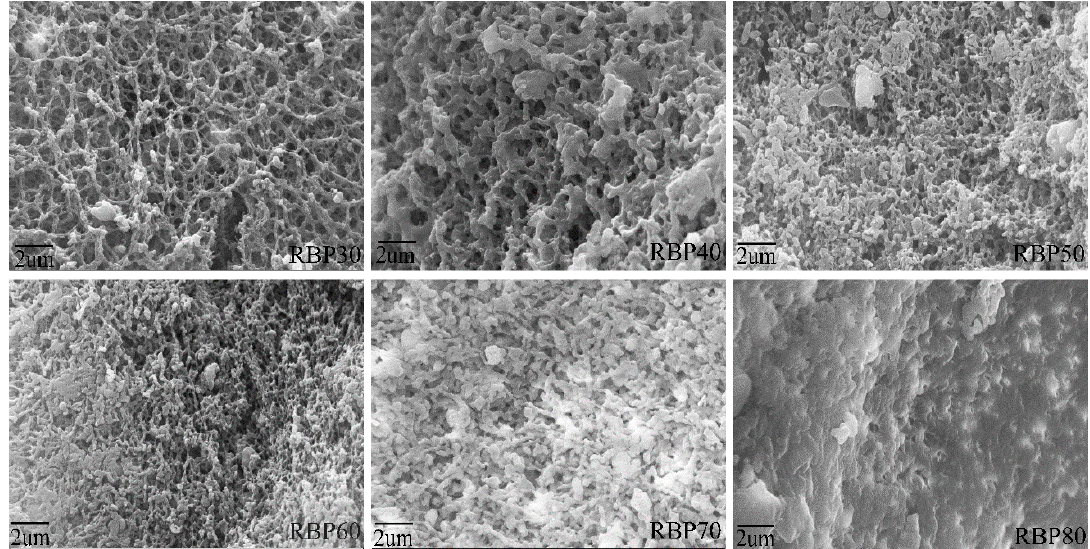
Figure 4. SEM images of RBPs extracted at different temperatures.